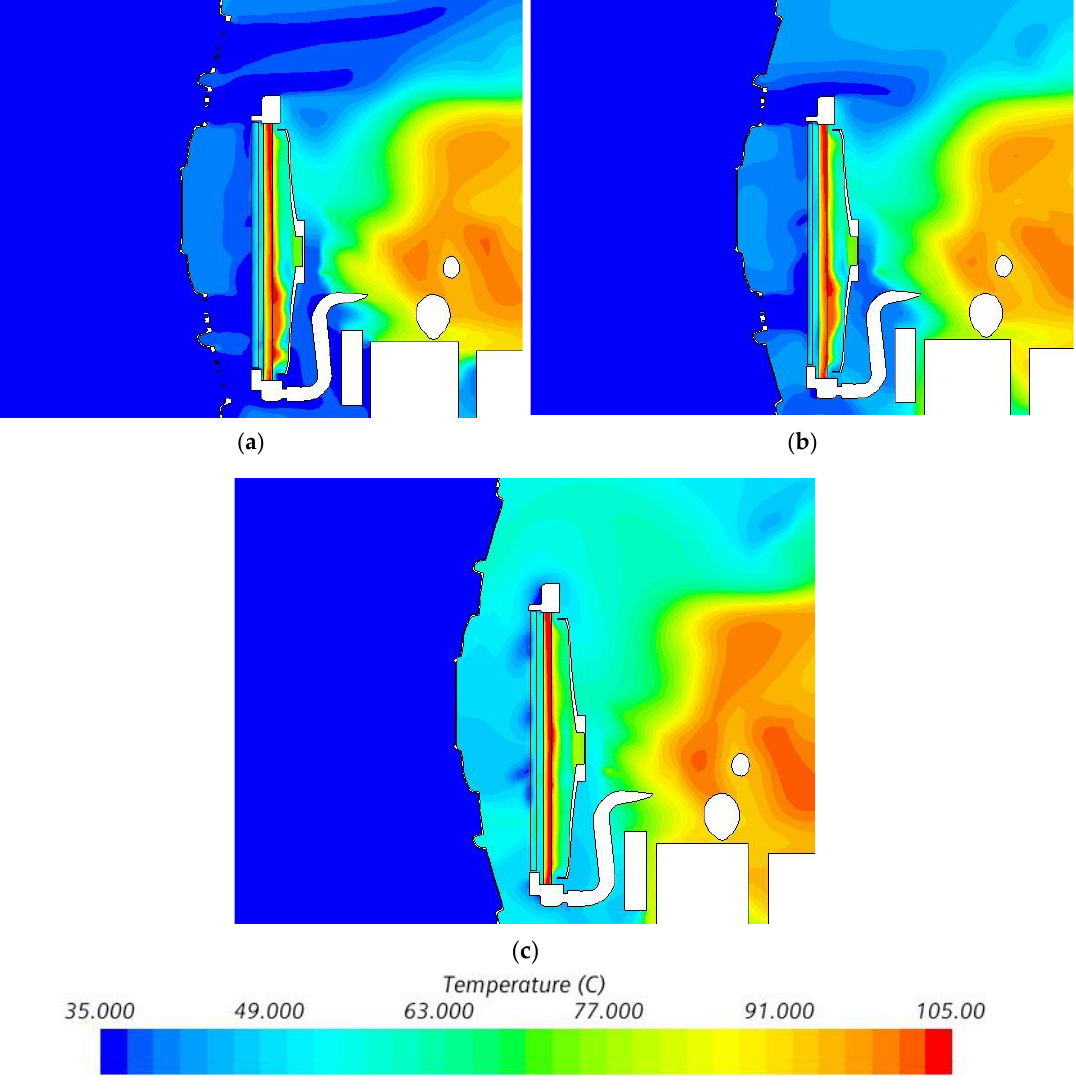
Figure 14. Temperature fields of z = 0.44 m section under different upper grille closure schemes: ( a ) original vehicle; ( b ) scheme 1; ( c ) scheme 2.